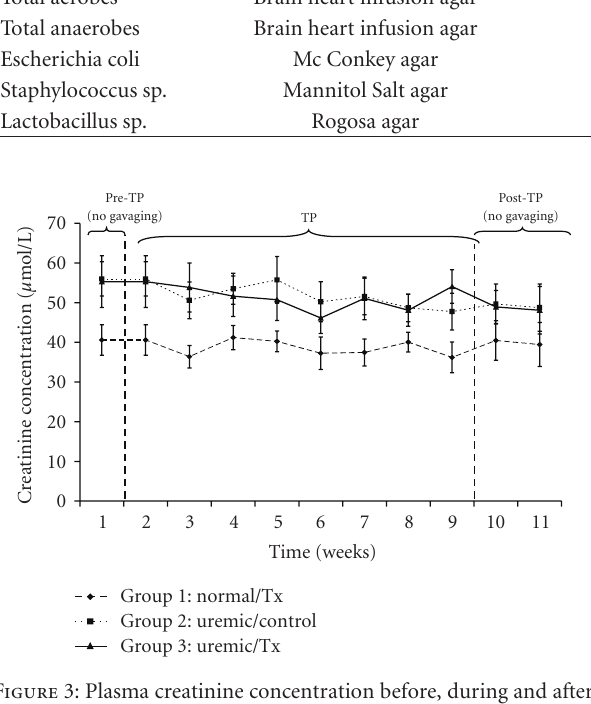
Figure 3: Plasma creatinine concentration before, during and after oral administration of APA microencapsulated yeast cells.